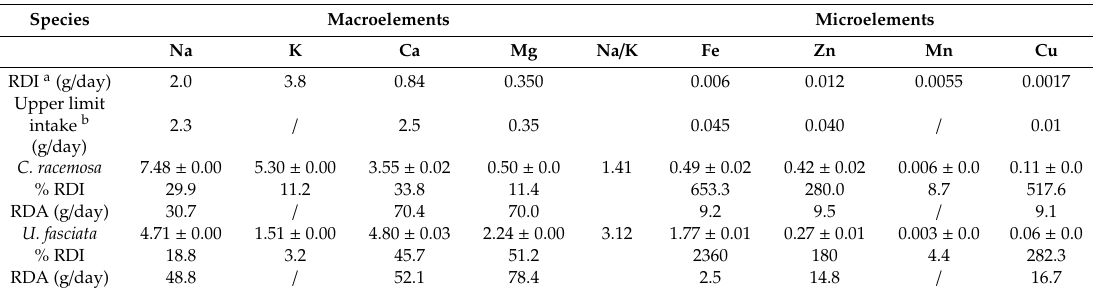
Table 6. Composition of macroelements and microelements (% of algal dw), recommended daily intakes, and recommended daily allowances of C. racemosa and U. fasciata